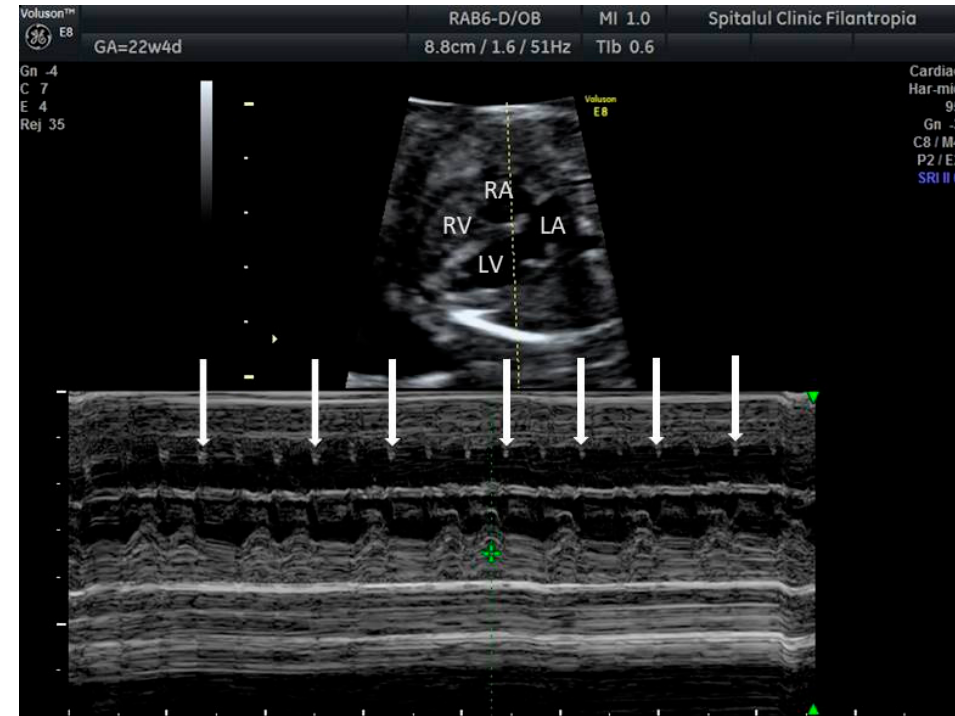
Figure 6. Second degree fetal heart block. Arrows indicate atrial contractions.